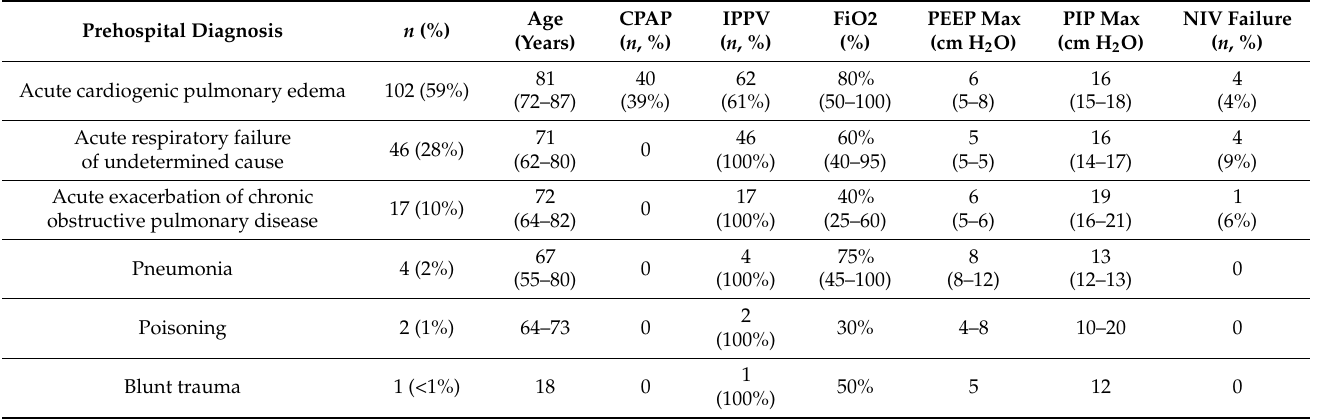
Table 1. Prehospital data of the 172 patients treated with noninvasive